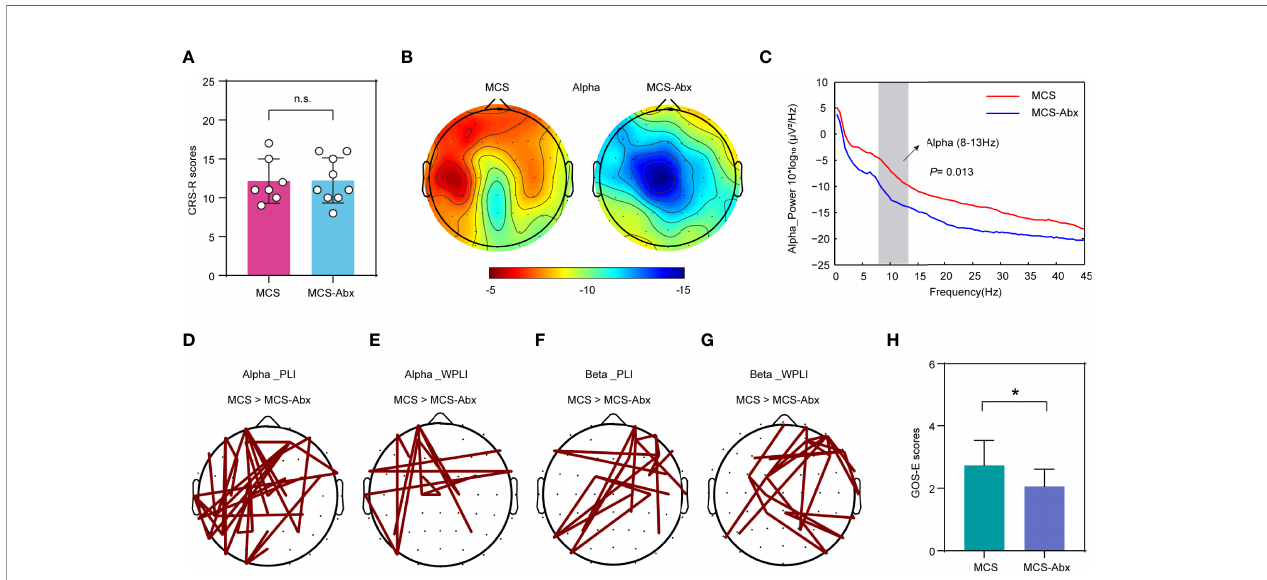
FIGURE 5 | Comparison of the behavioral scale and EEG signals of MCS patients with and without antibiotic treatment. (A) Comparison of the CRS-R scores of the patients with EEG recordings in the MCS and MCS-Abx groups. Data represent the mean ± SD. (B) Topography of the average degree of the alpha band power for the two groups. Red indicates greater alpha band power. (C) Spectral power in the MCS and MCS-Abx groups. Averaged alpha power for the differential electrodes (number of sites: 3, 5, 6, 11, 17, 18, 20, 21, 24, 28, 30, 31, 36, 38, 42, 44, and 48). The vertical gray bar highlights the portion of the graph corresponding to the alpha frequency ranges, both of which showed a signi fi cantly decreased power in the MCS-Abx group ( p = 0.013). The red line denotes the MCS group and the blue line indicates the MCS-Abx group. (D – G) Connected topoplot of the PLI and WPLI between the MCS and MCS-Abx groups in the alpha and beta bands. NBS was used to identify the interregional connectivity that signi fi cantly differed between the groups for the alpha and beta bands. Red lines indicate higher connectivity in the MCS group than that in MCS-Abx group. (D) PLI in the alpha band ( p = 0.010). (E) WPLI in the alpha band ( p = 0.039). (F) PLI in the beta band ( p = 0.002). (G) WPLI in the beta band ( p = 0.006). (H) Comparison of the GOS-E scores followed for 6 months between the MCS and MCS-Abx groups. Data represent the mean ± SD. P -values were determined using Student ’ s t -test or the Kruskal – Wallis test and were corrected using FDR. * p < 0.05; n.s. , no signi fi cant difference. PLI , phase lag index; WPLI , weighted phase lag index; NBS , network-based statistic; CRS-R , Coma Recovery Scale — Revised scores; GOS-E , Glasgow Outcome Scale — Extended; MCS , minimally conscious state; Abx , antibiotic; FDR , false discovery